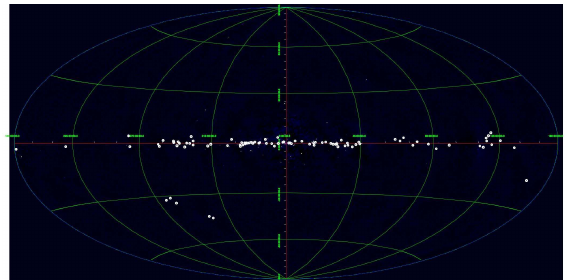
Figure 3: Distribution of HMXBs (white filled circles) in the 20-100 keV sky imaged by IBIS. They lie along the Galactic plane.